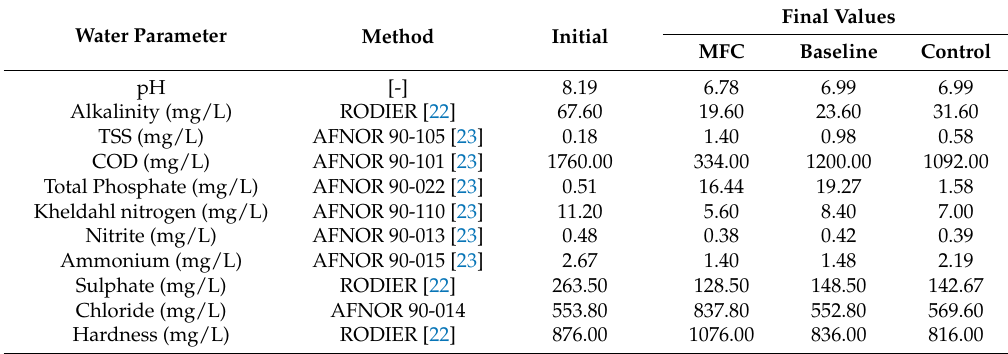
Table 1. Comparison of physicochemical parameters before and after water treatment in microbial fuel cells (MFCs), baseline and